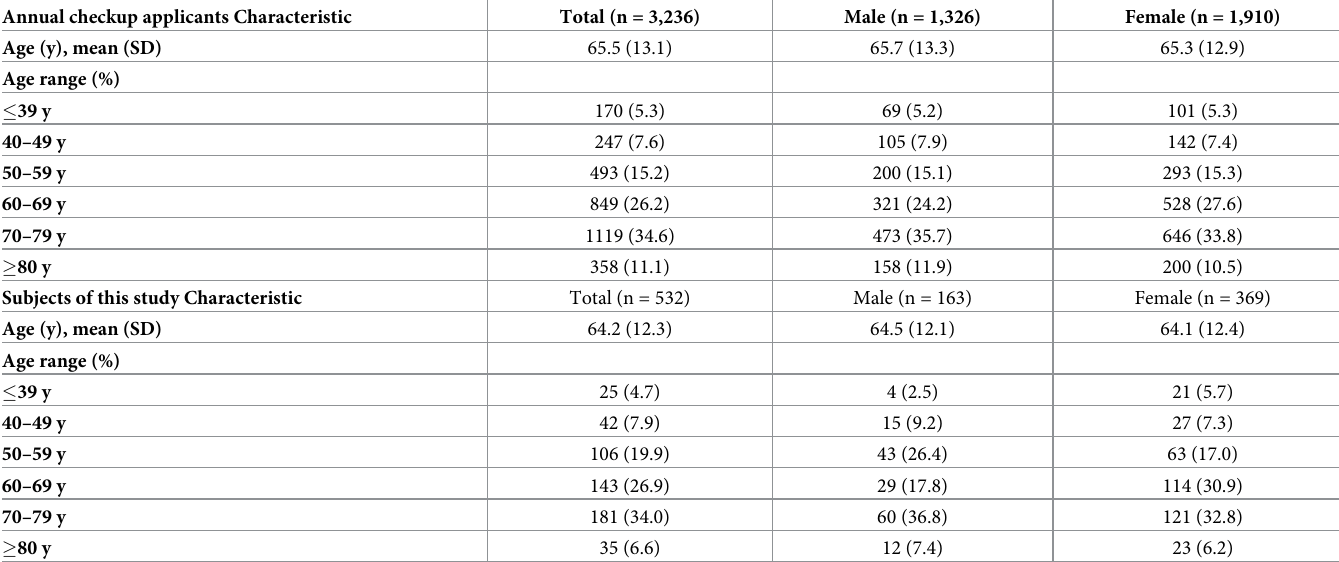
Table 1. Characteristics of annual checkup applicants and subjects of this study.